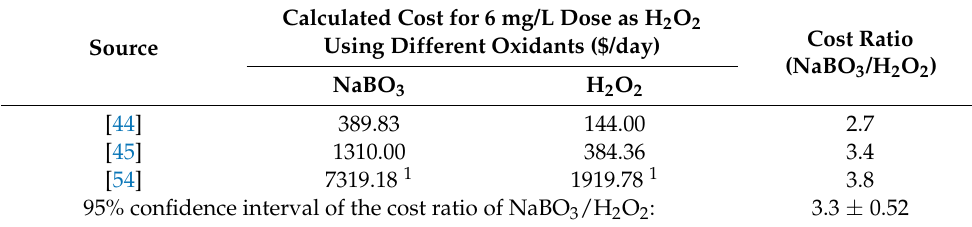
Table 5. Calculated NaBO 3 to H 2 O 2 Chemical Cost Ratio using Quotes from Single